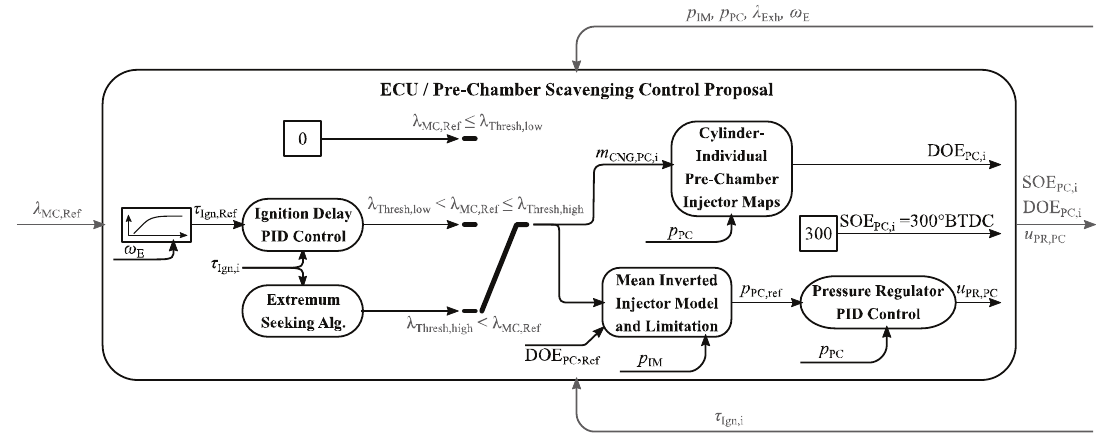
Fig. 12. Extended pre-chamber scavenging control suggestion. Depending on the main chamber air-to-fuel ratio, the strategy is to either control the igni- tion delay with the amount of CNG injected into the pre-chamber, or to minimize the ignition delay with an extremum seeking algorithm. For lower λ MC,Ref values, no injection is needed. Acceptable values for the strategy switching thresholds are λ Thresh,low = 1.6 and λ Thresh,high =